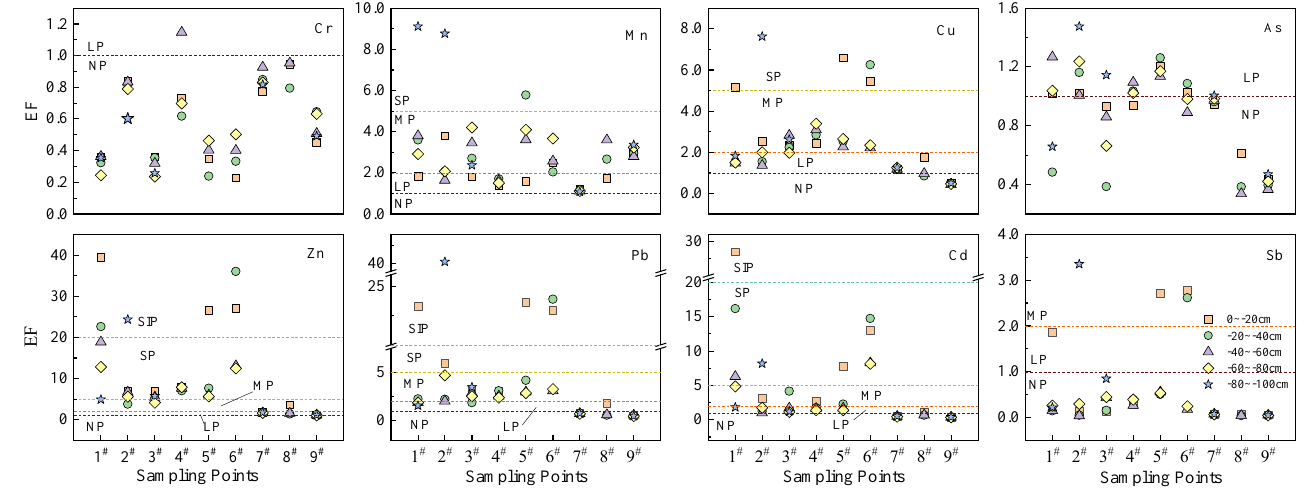
Figure 5. The degree of heavy metal pollution in the study area. (Note: different color lines represent EF values: 1, 2, 5, 20; NP: no pollution; LP: light pollution; MP: moderate pollution; SP: severe pollution; SIP: significant contamination; Orange squares represent sampling points with depths from 0 to − 20 cm; green dots represent sampling points with depths from − 20 to − 40; purple triangles represent sampling points with depths from − 40 to − 60; yellow diamonds represent sampling points with depths from − 60 to − 80 cm; and blue pentagons represent sampling points with depths from − 80 to − 100 cm).